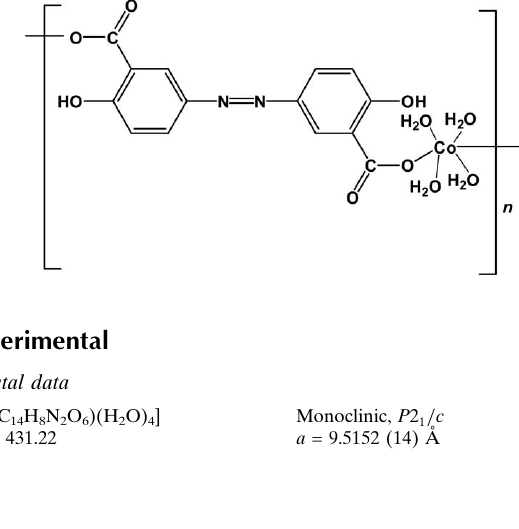
Related literature